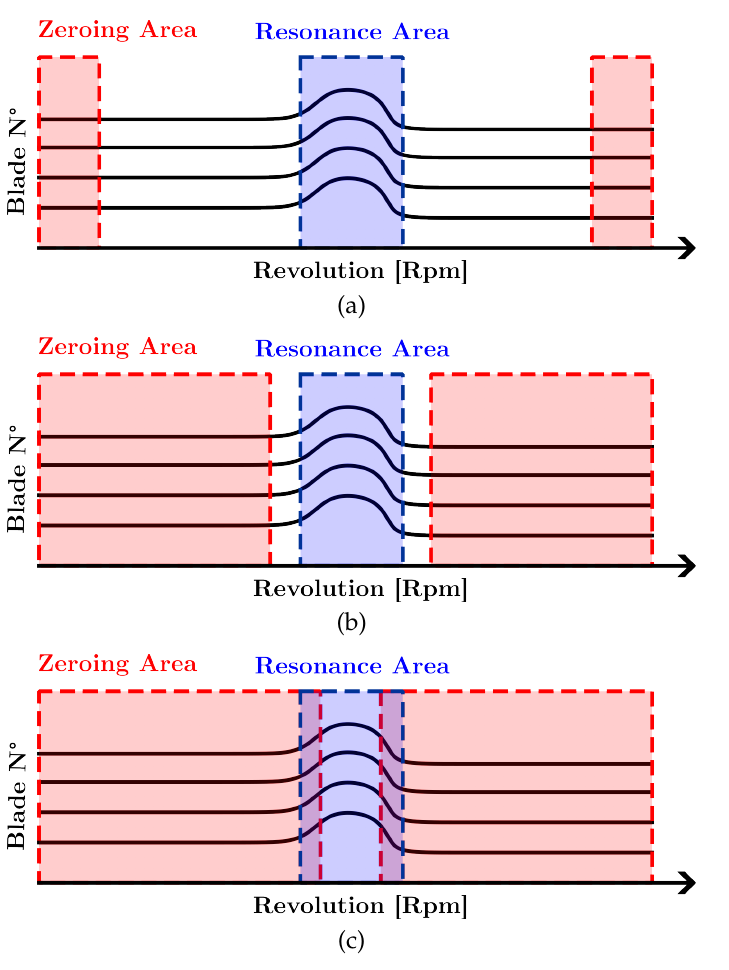
Figure 8. Scheme of the zeroing application. Deflections suffered by each blade (the plots are stacked vertically) as the number of revolutions (RPM) increases. The box in blue highlights the resonance area and red highlights the one chosen for the zeroing. Different types of zeroing are applied: ( a ) thin zeroing; the red zone is small and includes only the deflection at the lowest and highest RPM regime ( b ) large zeroing; the red zone is quite large, and includes deflection relative to wider RPM regions but it does not include part of the resonance area, ( c ) very large; the red zone is very large and it includes part of the resonance area.